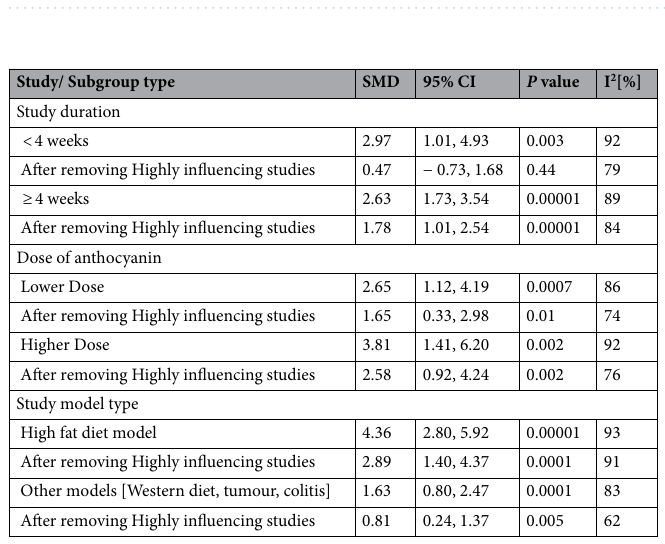
Table 4. Pooled effects of anthocyanins from various sources on short chain fatty acid profile including all- inclusive and high-influencer studies. Pooled effect sizes and 95% CI were determined using Random effects model. SMD Standardised mean difference, I 2 Heterogeneity.